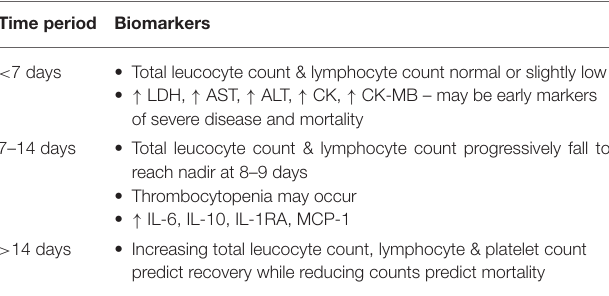
TABLE 3 | Temporal course of biomarkers in